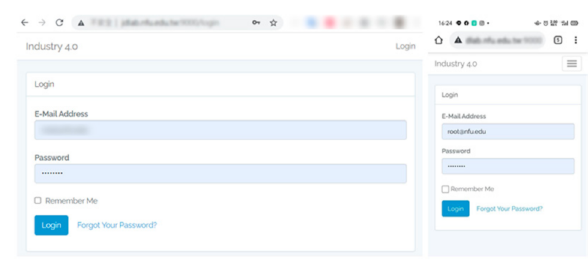
Figure 14. Login permission.